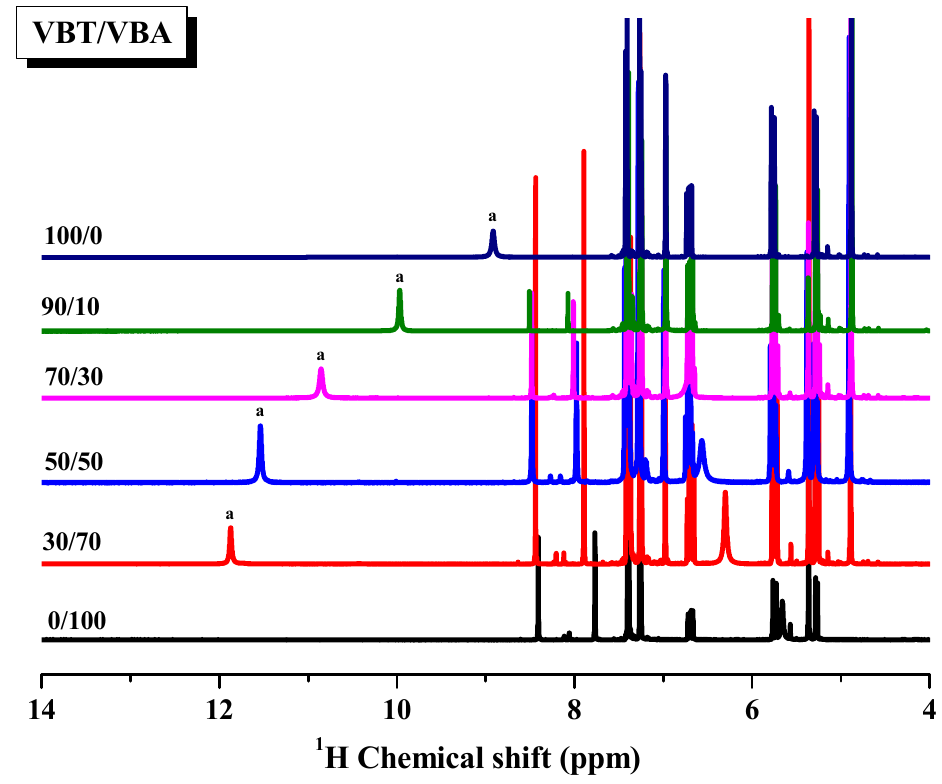
Figure 9. 1 H NMR spectra displaying the chemical shift of the NH groups of VBT/VBA mixtures of various